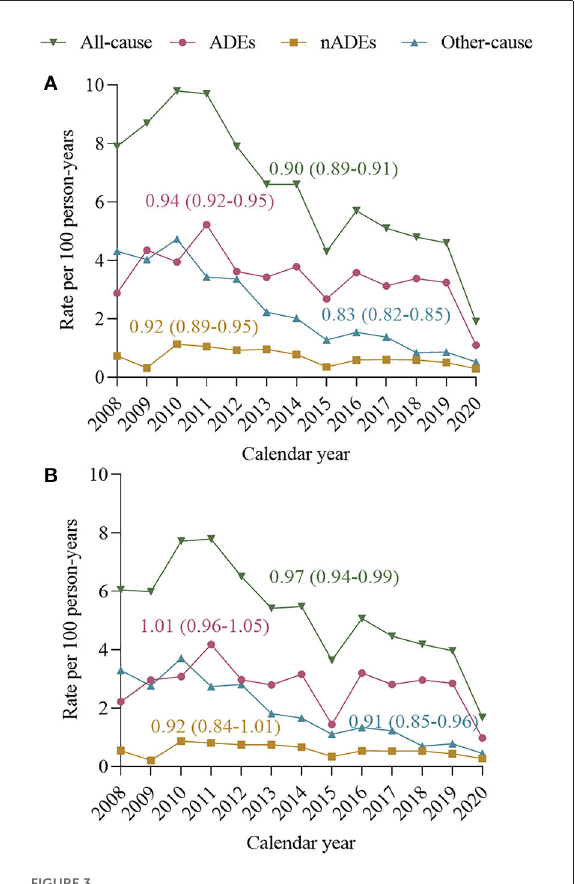
FIGURE3 Incidence rate ratios (IRRs) and 95% confidence intervals (95% CI) calculated using Poisson regression models. Annual hospitalization rates and mean rate change, 2008–2020, for all-cause hospitalizations, ADE-related hospitalization nADE-related hospitalization and other-causes hospitalization. (A) Unadjusted annual all-cause and cause-specific hospitalization rates. (B) Annual all-cause and cause-specific hospitalization rates, standardized to age, sex, HIV transmission risk, CD4 count, and VL distribution of person-years in 2014. Standardization strata were defined according to the